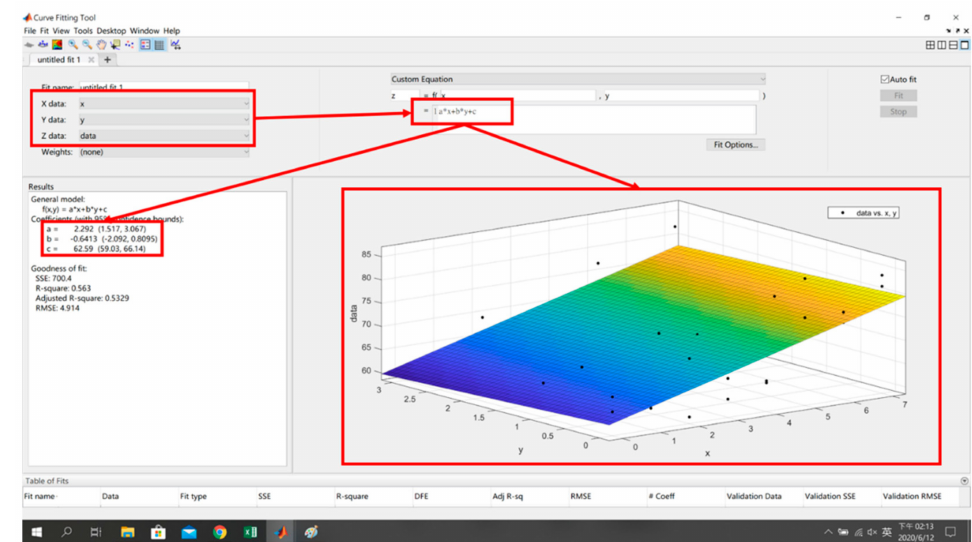
Figure 10. Planar Model and Equation Generation.